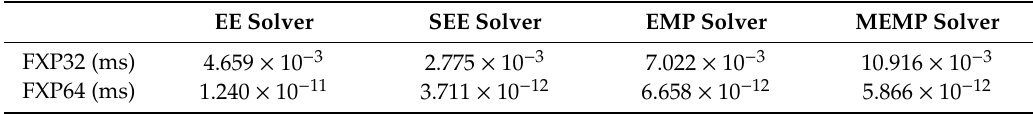
Table 3. The maximum values of discrepancy in the time of occurrence of the second spike for DBL and FXP solvers while sending two pulse signals with amplitude A = 12 µA.